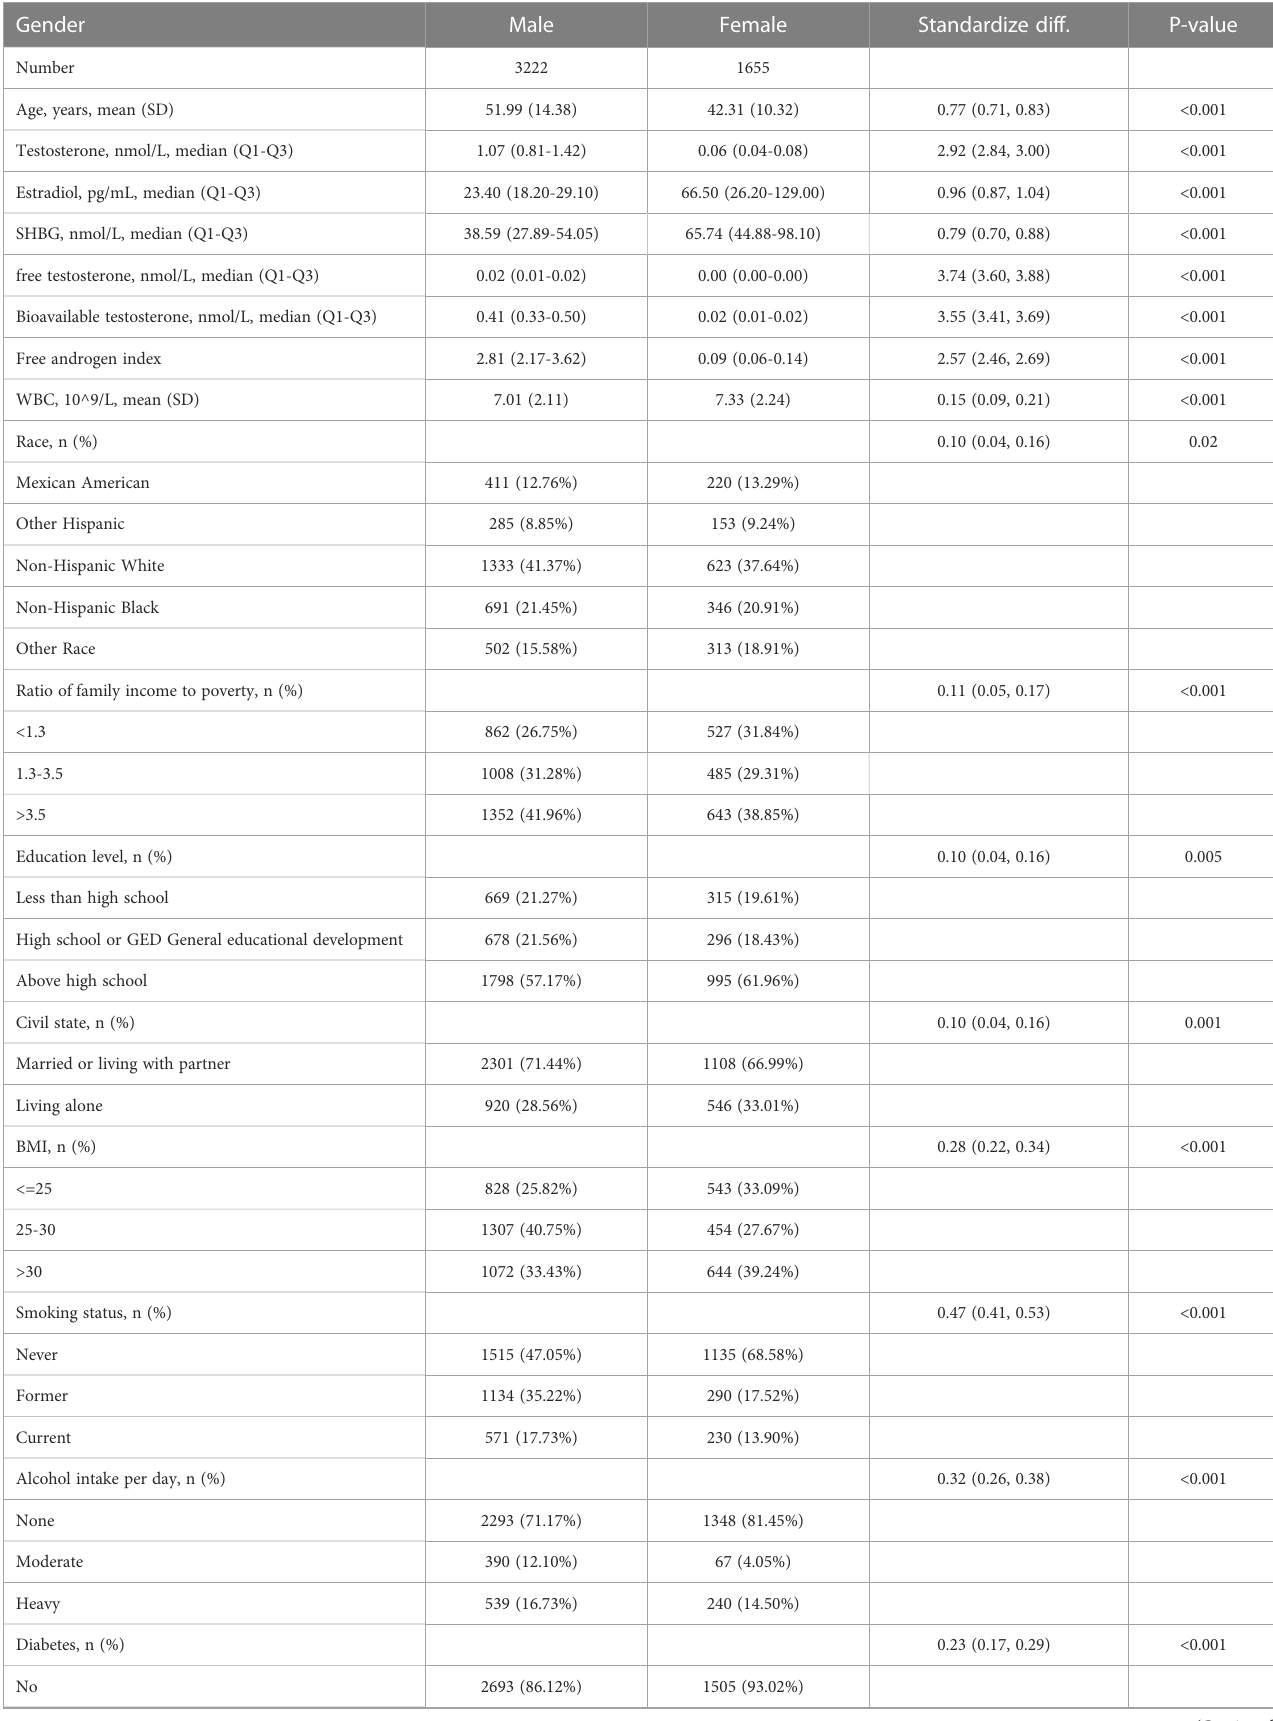
TABLE 1 Baseline characteristics of NHANES participants between 2009 and 2014 in male and female groups (n = 4877). Gender Male Female Standardize